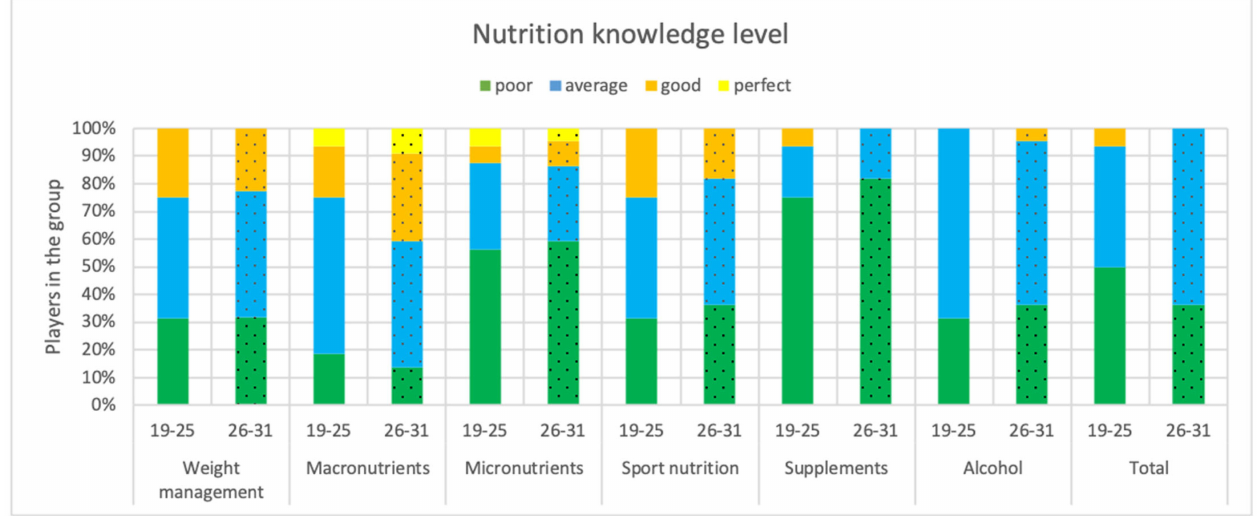
Figure 5. Nutritional awareness of participating players by age category (n =